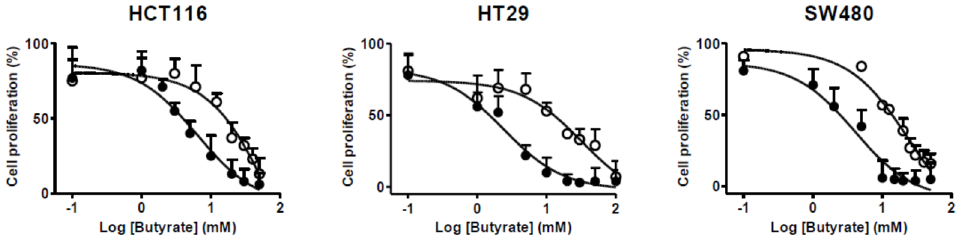
Figure 1. Effects of sodium butyrate on the cell proliferation in colon cancer cells. Cell proliferation was evaluated with an MTT assay in parental (PT, ●) and butyrate-resistant (BR, ○ ). HCT116 and SW480 cells were incubated with 0–50 mM of sodium butyrate for 72 h. HT29 cells were incubated with 0–100 mM of sodium for 72 h. The data are expressed as mean ± standard deviation of triplicate experiments. Table 2. Mean IC 50 ± standard deviation ( n = 3) of sodium butyrate, oxaliplatin, doxorubicin, and 5-fluorouracil in PT and BR human colon cancer cells of HCT116, HT29, and SW480. Drugs HCT116 Sodium butyrate (mM)